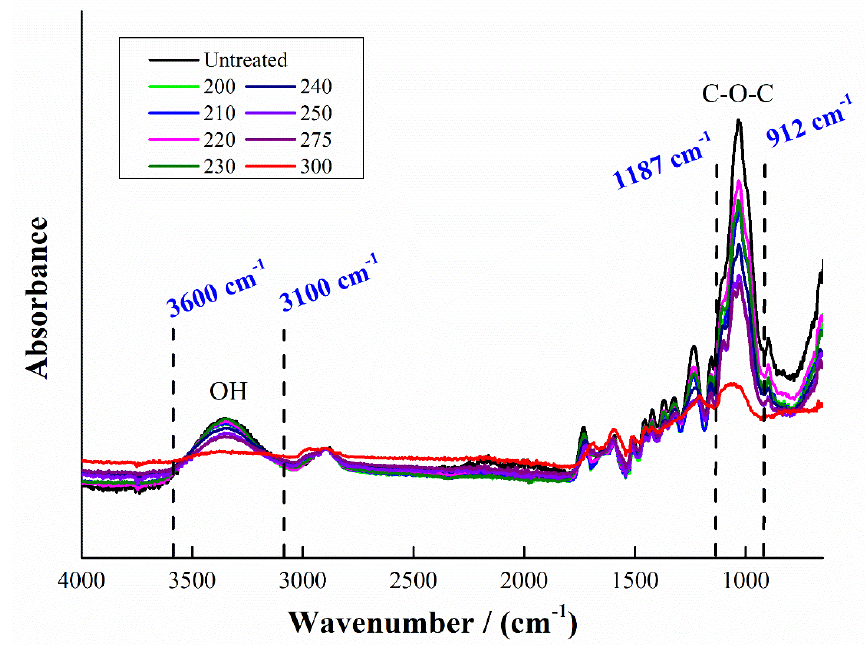
Figure 14. FTIR spectra of beech wood after heat treatment at 200–300 °C.